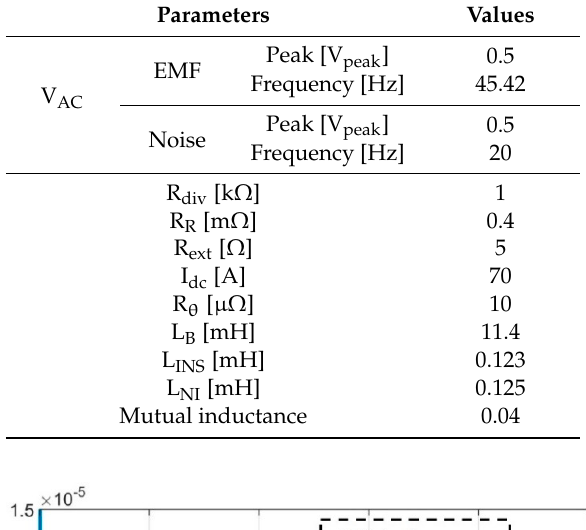
Table 1. Specifications of the simulation parameters and values.